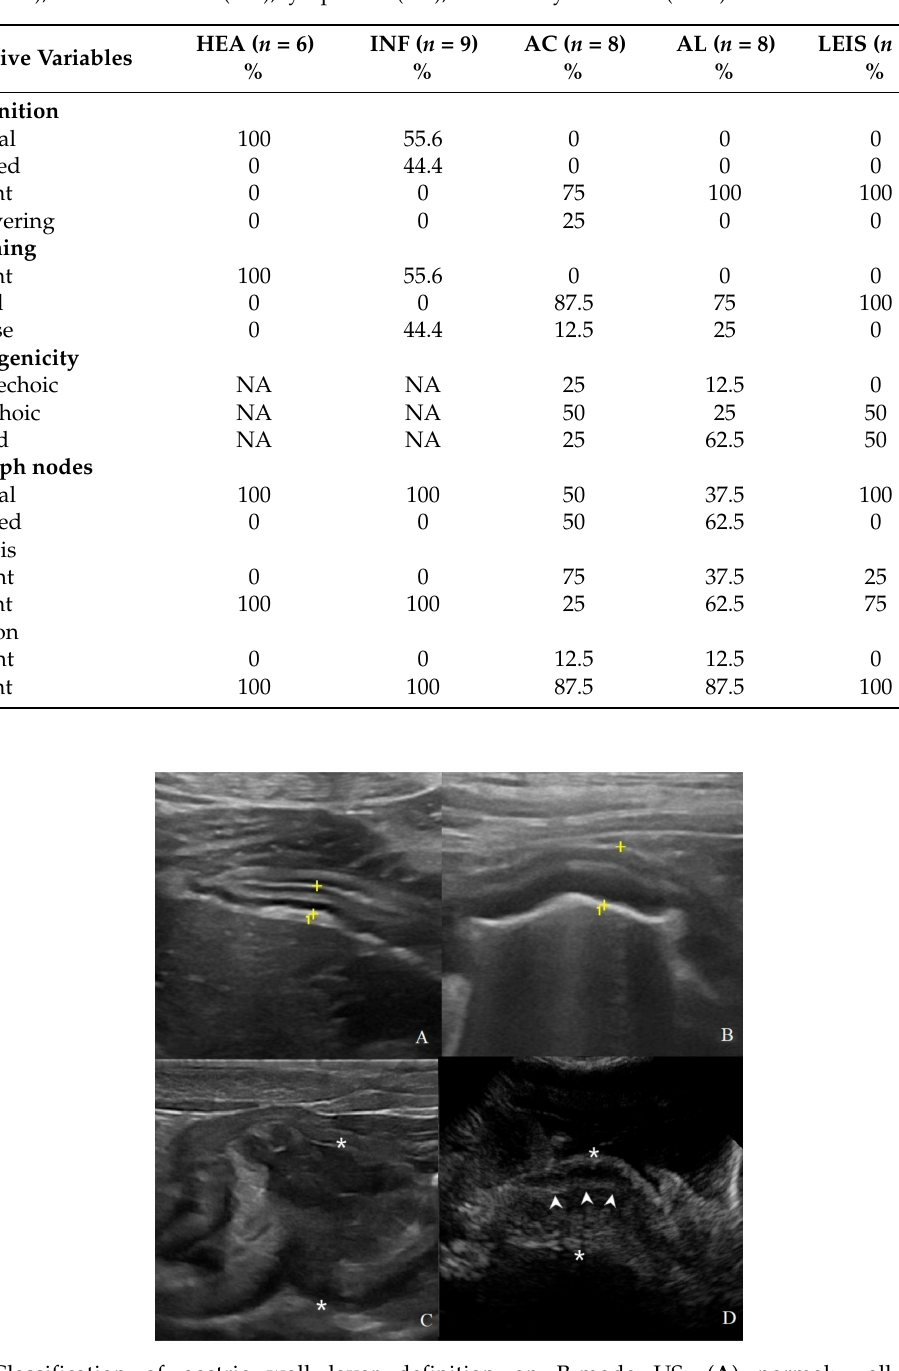
Figure 2. Classification of gastric wall layer definition on B-mode US: ( A ) normal: all the five lay- ers are easily identified and thickness is normal, (4.1 mm between the cursors (+) in a HEA dog); ( B ) reduced: the identification of the layers is more difficult; in addition to a mild diffuse wall thickening (6.5 mm between the cursors in a INF dog); ( C ) absent: it is not possible to recognize the normal wall stratification and layer definition is lost. Here, a focal transmural mass of 37.5 mm between the asterisks in a gastrointestinal stromal tumor (GIST) with mixed echogenicity; ( D ) pseudolayering: wall, between the asterisk (*), with moderately echogenic line (arrowheads) surrounded by an outer and inner poorly echogenic areas in a dog with gastric